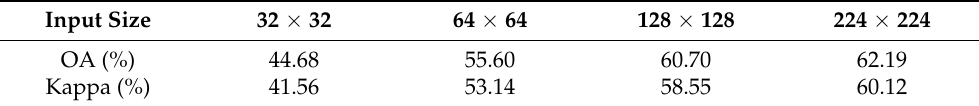
Table 4. Classification results of the different input sizes.